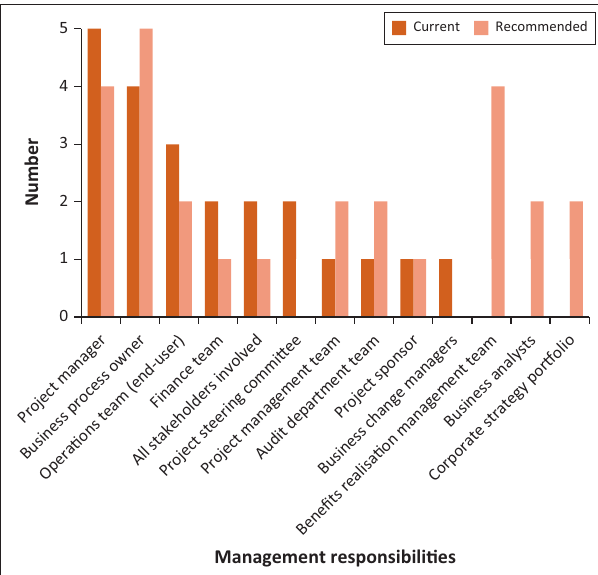
FIGURE 2: Comparison between current and recommended benefits realisation management